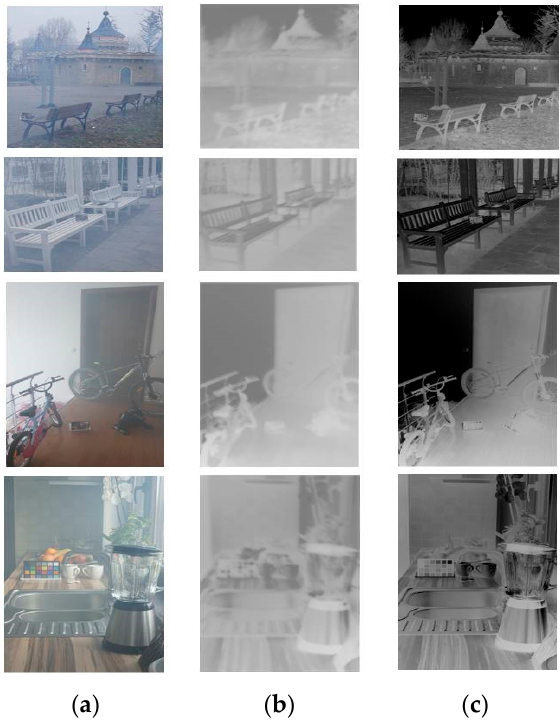
Figure 12. Transmission maps generated by TGL-Net (T TGL-Net ) and F-DCP (T F-DCP ) from hazy in-